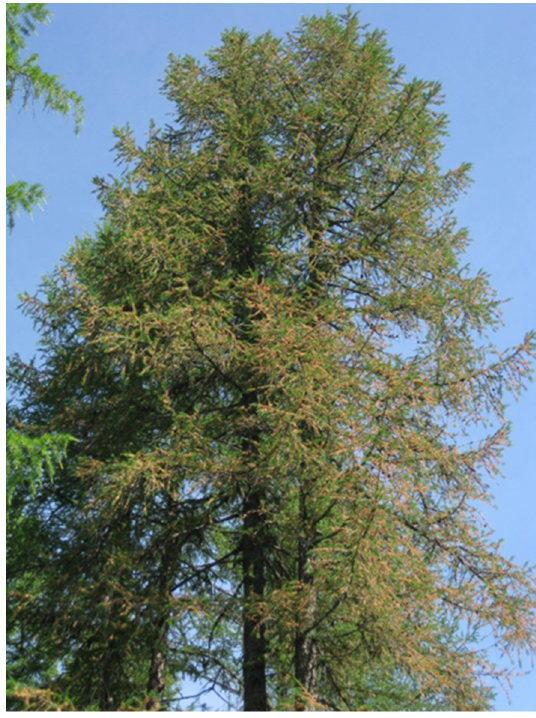
Figure 1. Massive 2011 outbreak of Hypodermella laricis in the Siberian larch stand planted in 1929, Kivalo Research Forest, 29 June 2011.